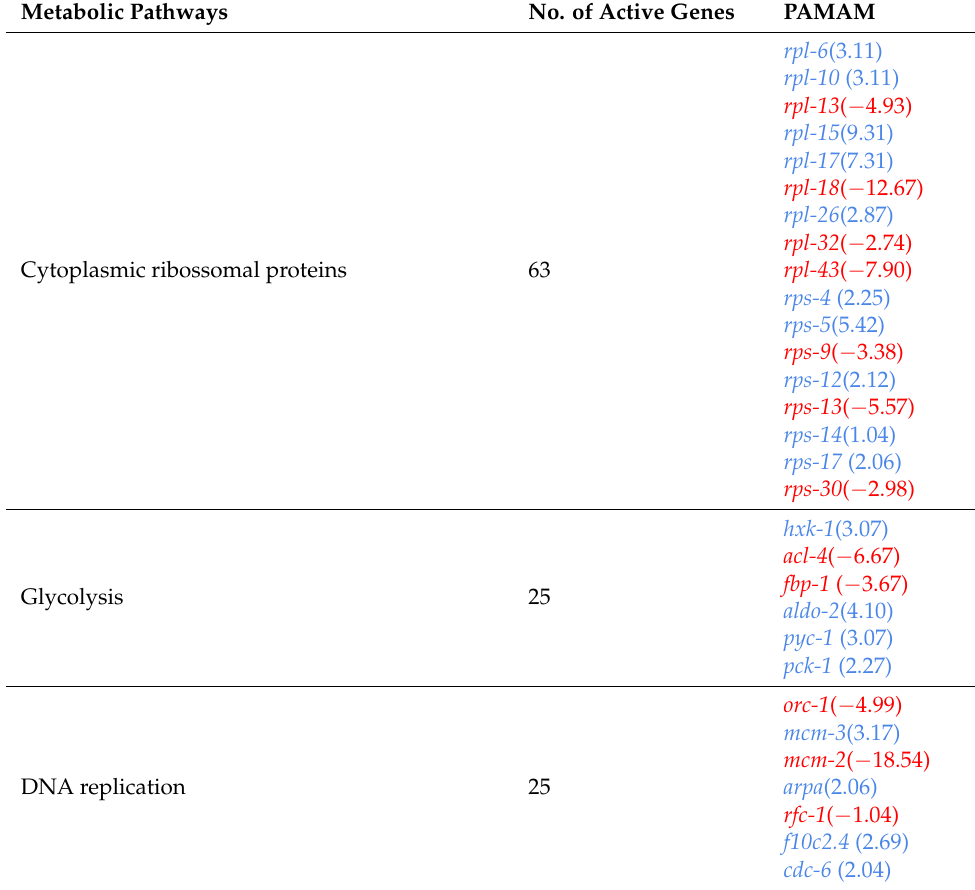
Table 2. Upregulated and downregulated genes of nematodes exposed to PAMAM. Metabolic